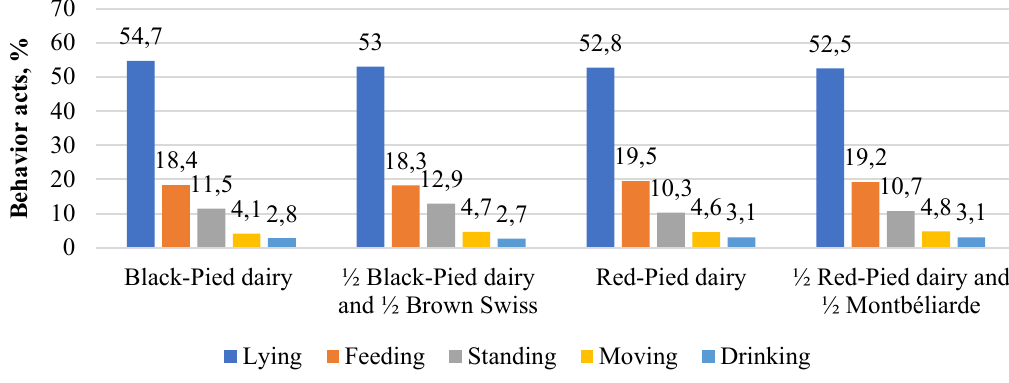
Fig.1. The main elements of the daily behavior of first-calf heifers of different origins